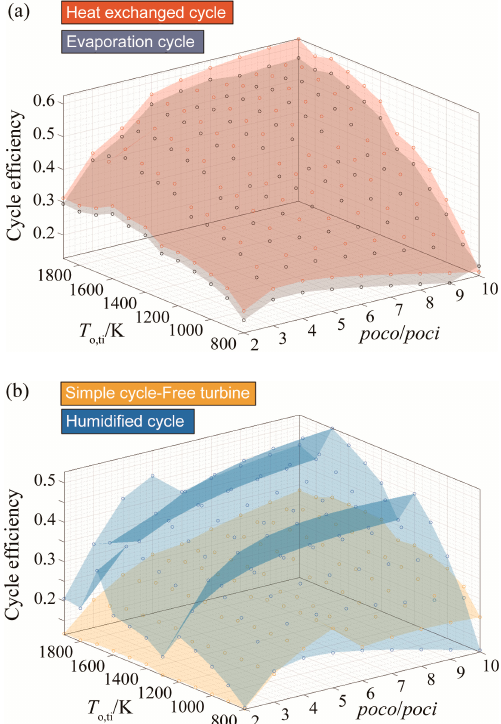
Figure 10. Efficiency results for ( a ) the heat exchanged cycle and the evaporative cycle and ( b ) the humidified cycle and the free turbine and simple cycle arrangement with respect to turbine inlet temperature variation.